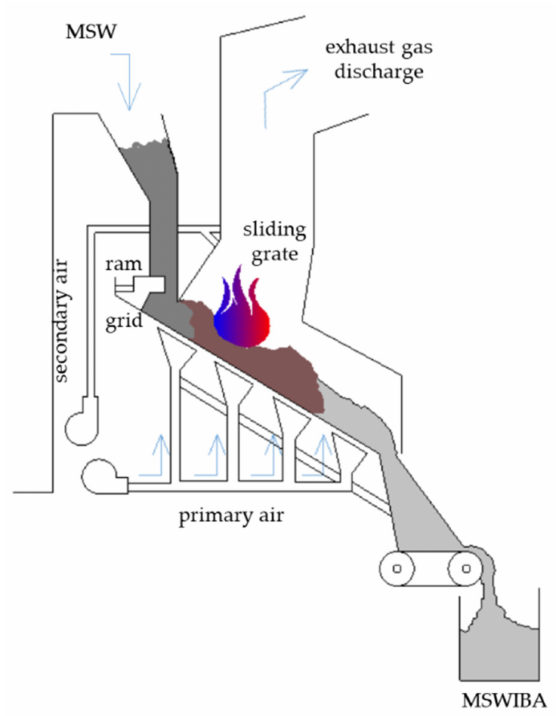
Figure 3. The process of thermal treatment of municipal solid waste and establishing the